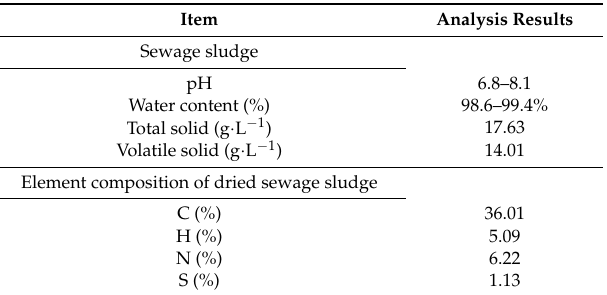
Table 1. Properties of the sewage sludge.